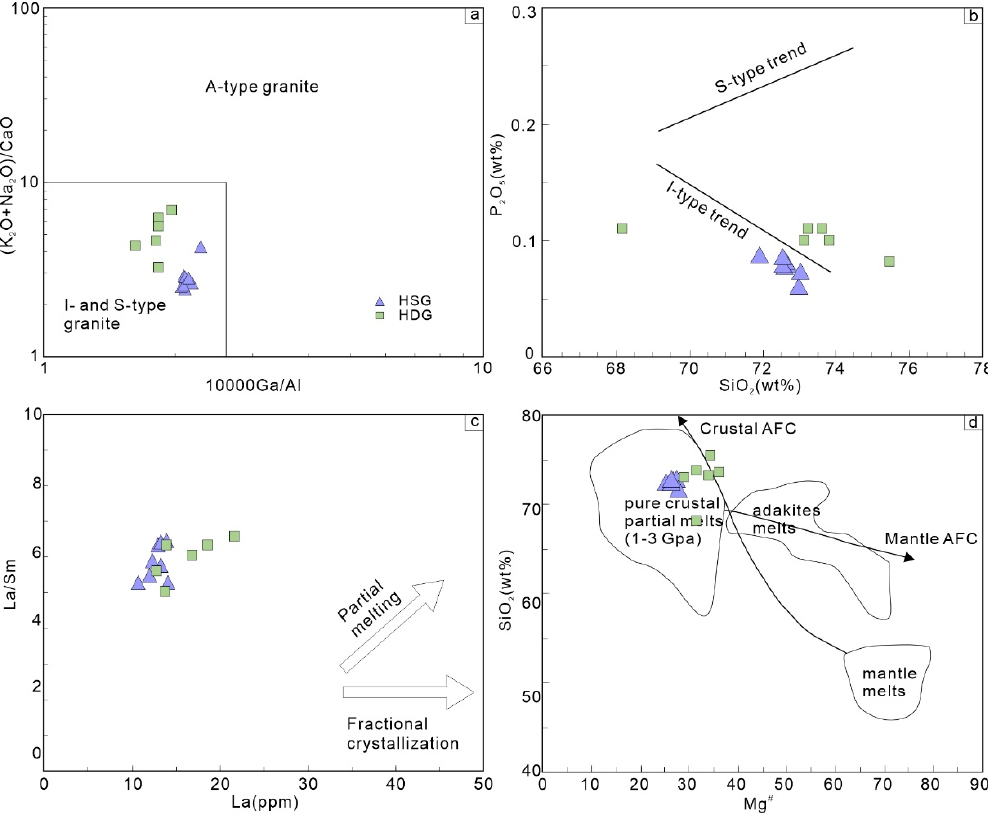
Figure 8. Geochemical affinity of the HSG and HDG. ( a ) (K 2 O + Na 2 O)/ CaO vs. 10000Ga/Al, after Whalen et al. [94]. ( b ) SiO 2 vs. P 2 O 5 diagrams, after Chappell [91]. ( c ) La/Sm vs. La, after Chung et al. [95]. ( d ) Mg # vs. SiO 2 diagram, after Gerdes et al. [96].